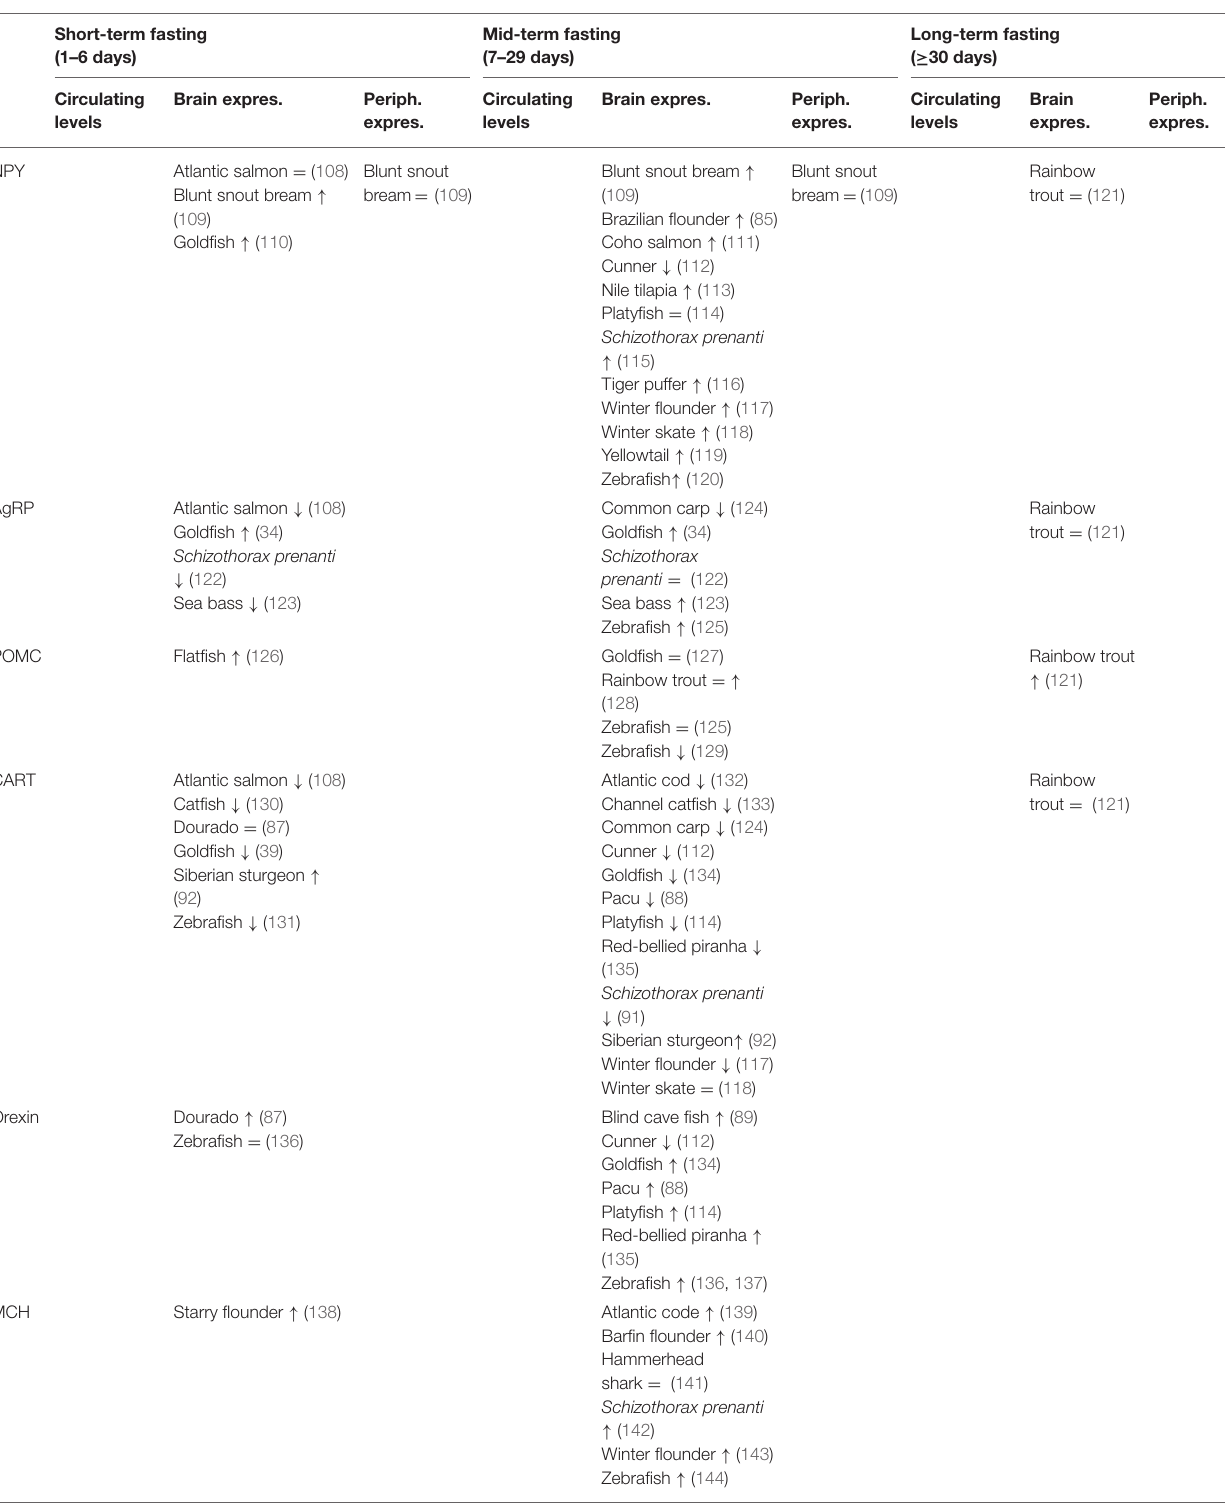
TABLE 2 | Effects of fasting periods of different duration on the circulating levels and the mRNA expression of the main appetite-regulating hormones in several fish